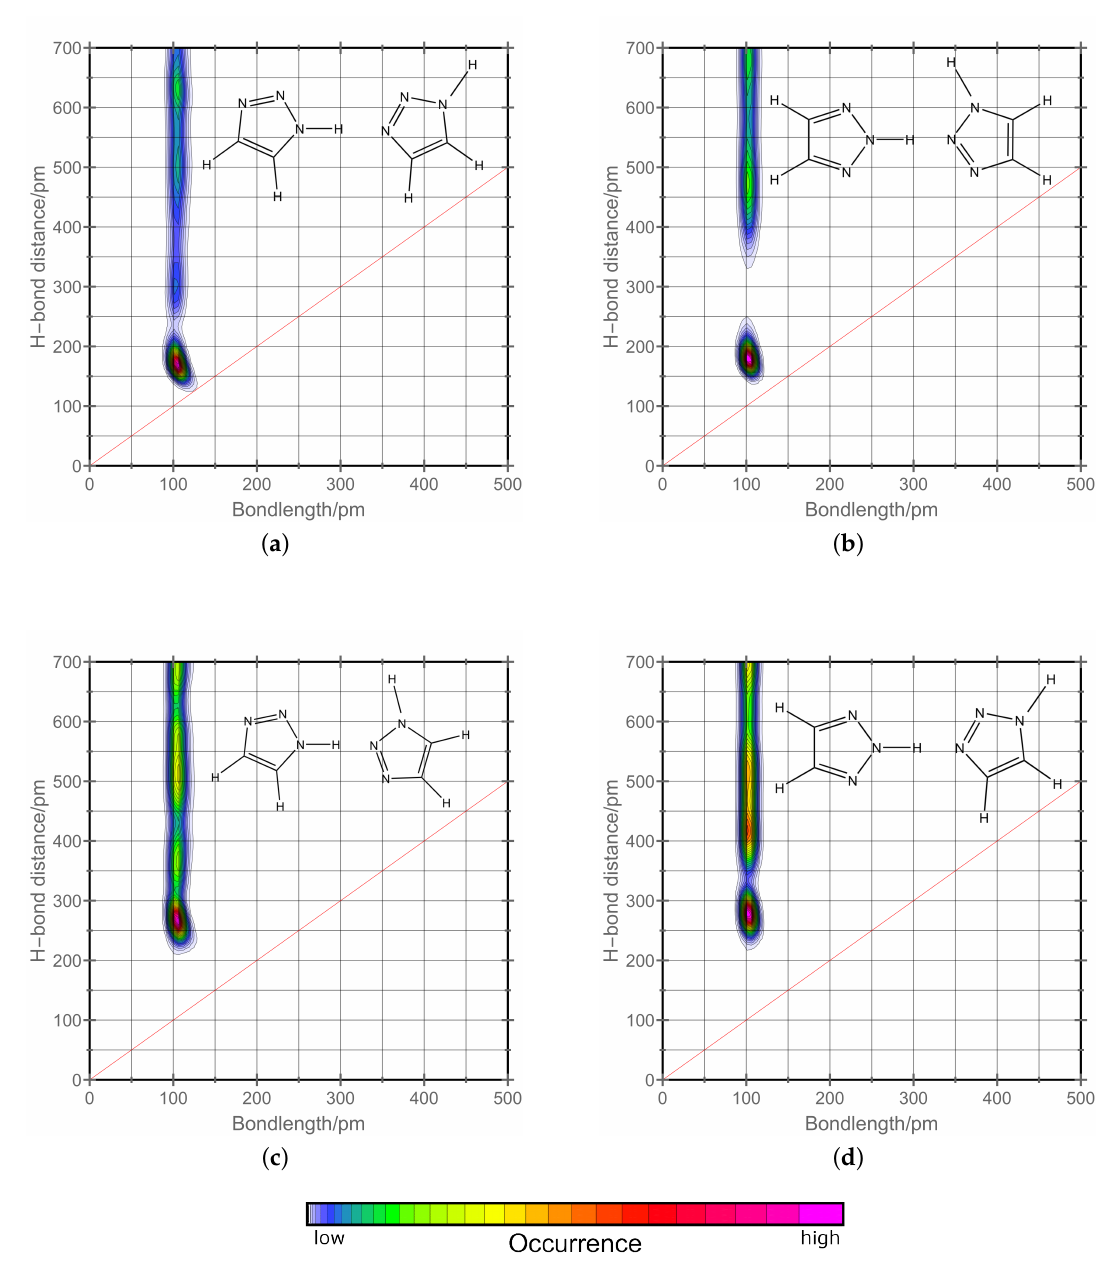
Figure 4. Combined distribution functions of the intramolecular nitrogen to hydrogen bond distance and the intermolecular distance of the acidic hydrogen to vacant nitrogen atoms in the monoclinic phase at 269K. On the left side hydrogen bonding between two 1H-triazole molecules ( a , c ) and on the right side hydrogen bonding between 2H- and 1H-triazole molecules is shown ( b , d ). Qualitatively, the same results are observed for the orthorhombic phase at 280K. The red line shows positions where both distance criteria have equal values. Lowermost, the color scheme for the qualitative probability of occurrence is given which holds for all the graphs